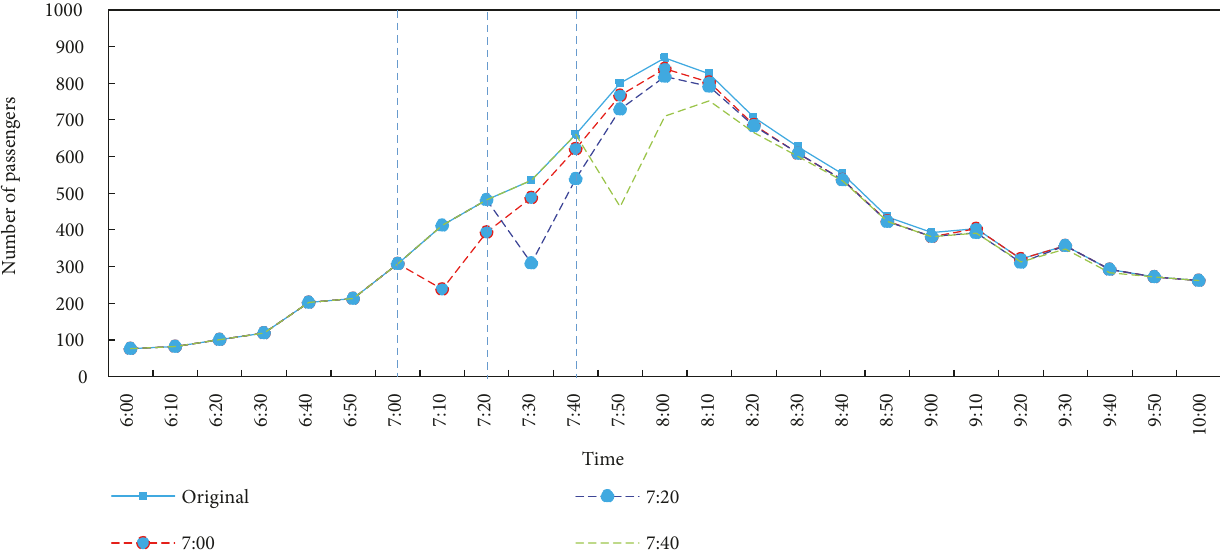
Figure 16: Estimated changes in demand for XZM station with different end times of the discount